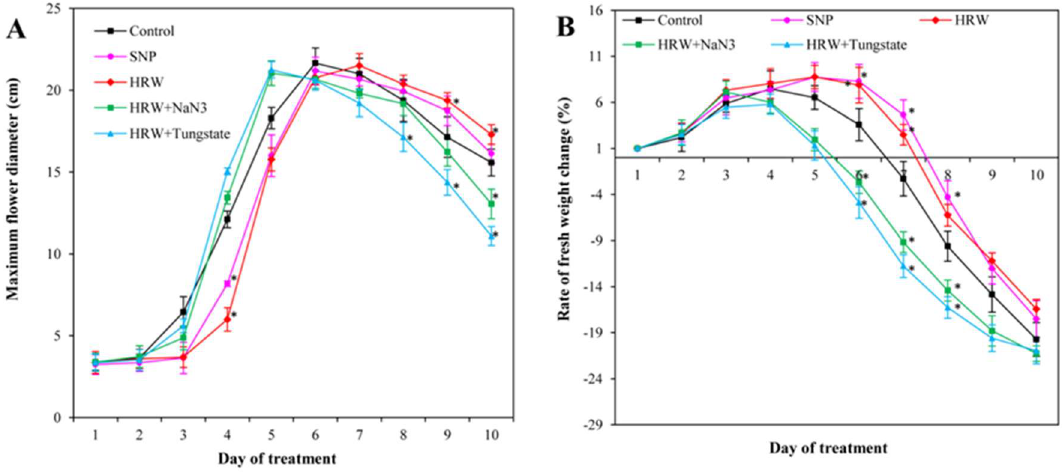
Figure 1. Effects of hydrogen-rich water (HRW), sodium nitroprusside (SNP), and HRW plus NaN 3 or tungstate on the vase life of cut lily flowers. The cut flowers were placed randomly in distilled water (control), 150 μM SNP, 1% HRW, 1% HRW + 50 μM NaN 3 and 1% HRW + 100 μM tungstate to investigate. The values of vase life ( A ) are the mean ± SE of three independent experiments. Bars with different letters illustrate significant differences ( p < 0.05) according to Duncan’s multiple range test. Photos ( B ) were taken after 8 days of treatments.